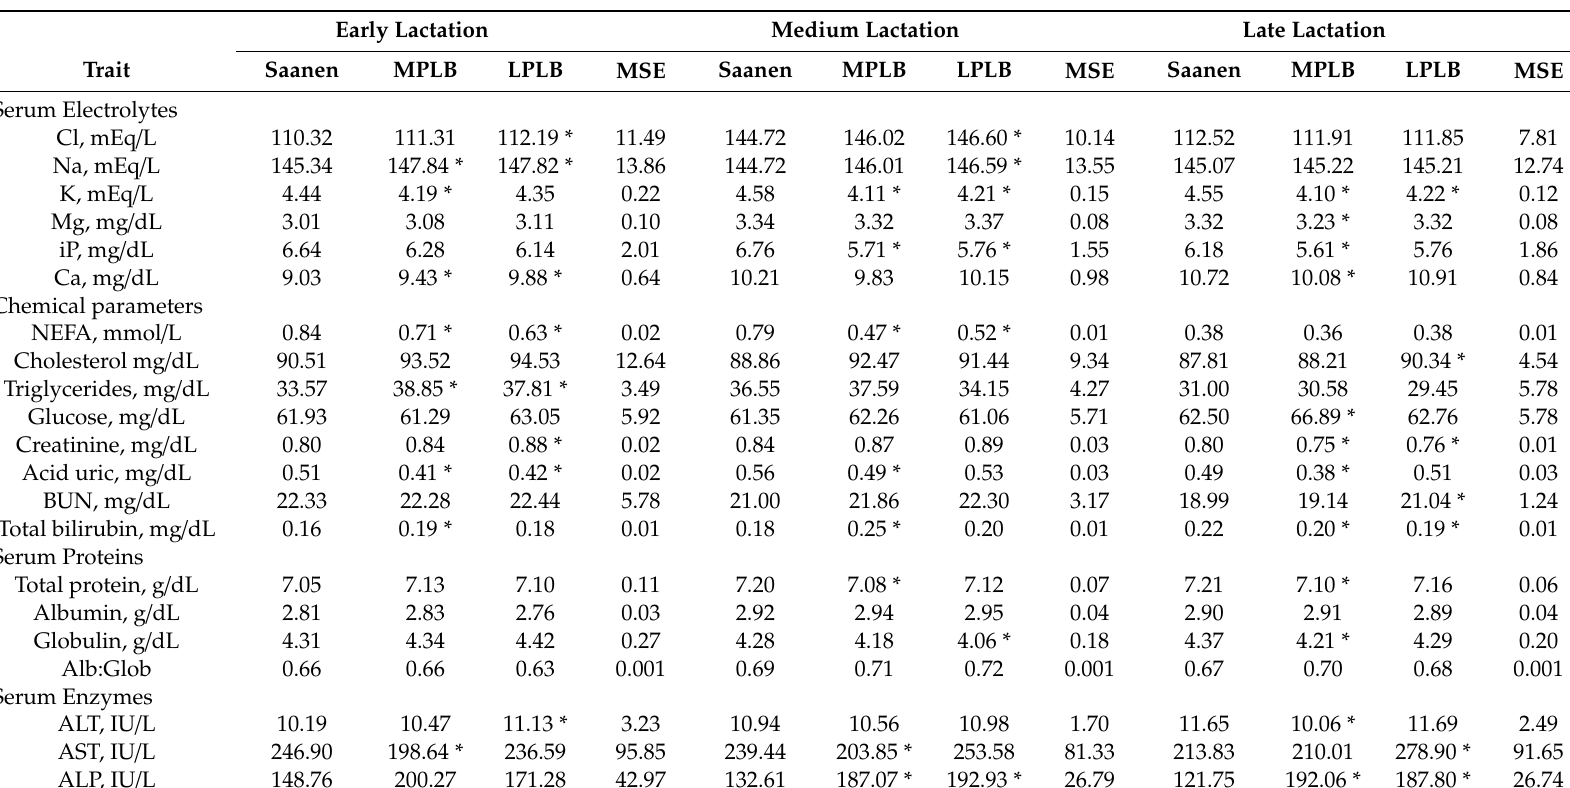
Table 3. Plasma mineral and metabolic profile (least squares means and mean standard error) of Saanen breed compared with Mediterranean medium production level breeds (MPLB: Maltese and Jonica breeds) and low production level breeds (LPLB: Rossa Mediterranea, Girgentana, and Garganica breeds) during early